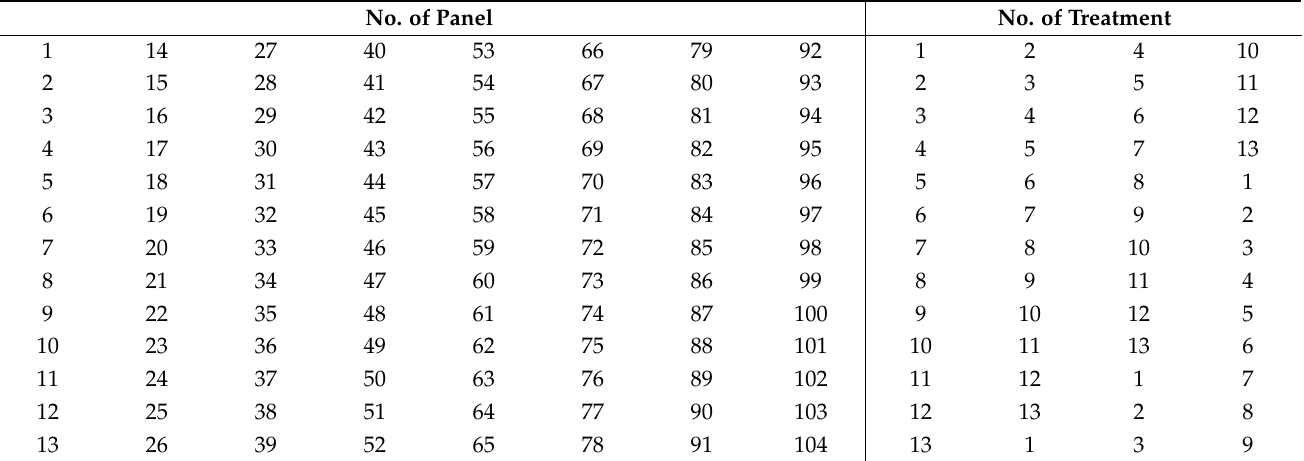
Table 2. The BIB (balance incomplete block design) of roasted rice germ flavored herbal tea infusion serving for